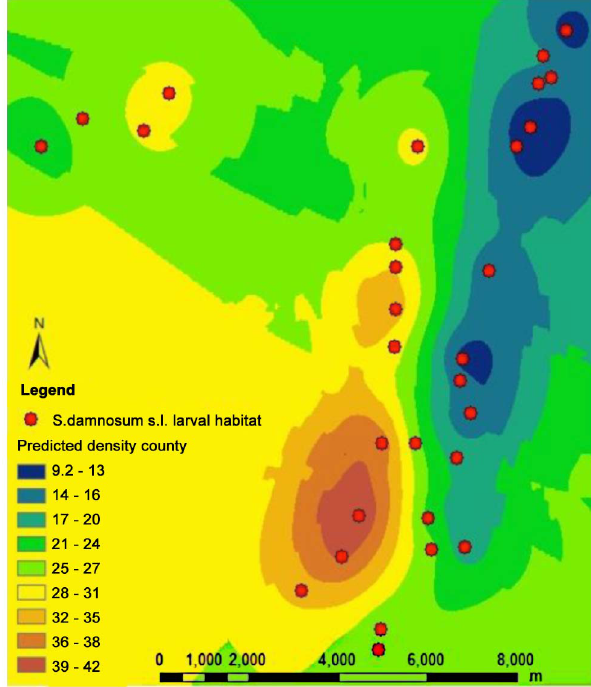
Figure 5. Predicted S.damnosum s.l. larval riverine sites in the Achwa River basin. Larval habitats were predicted using the BRR model as described in the text.